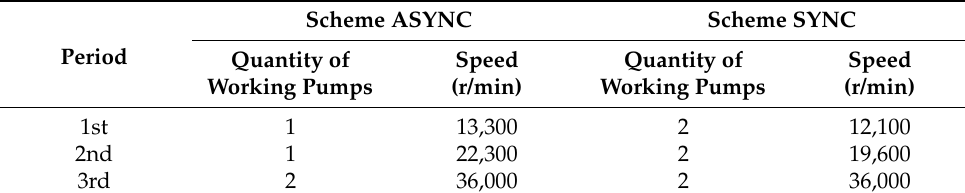
Table 6. Speed comparison between Scheme ASYNC and Scheme SYNC.